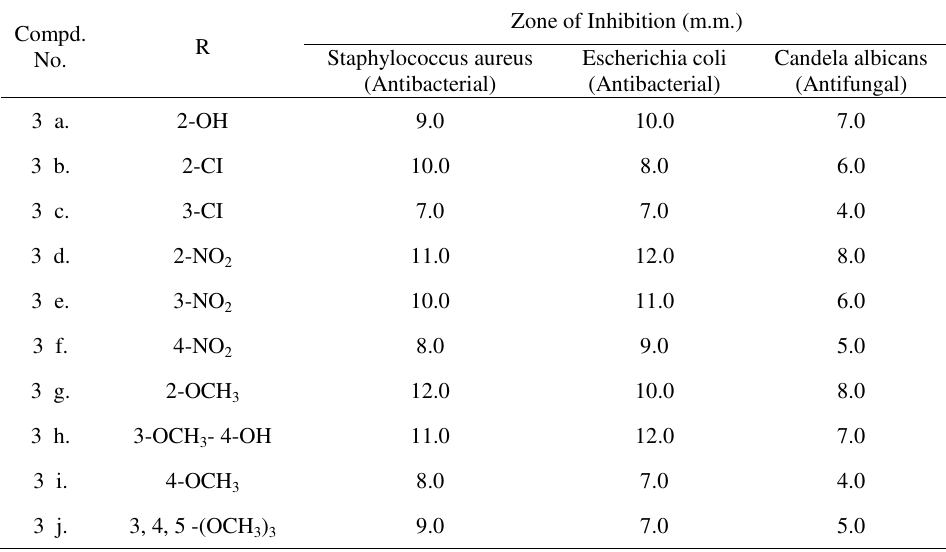
Zone of Inhibition (m.m.)